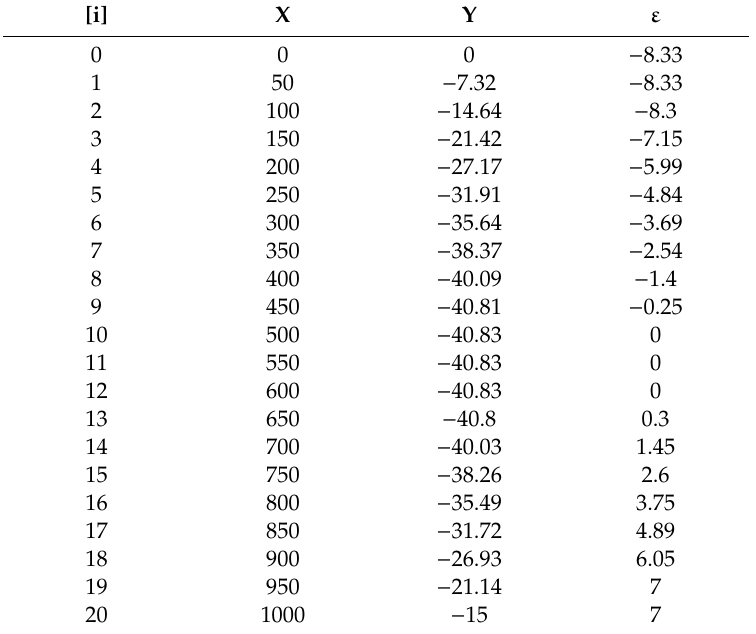
Table 4. Results for the trajectory being a combination of straight and curvilinear